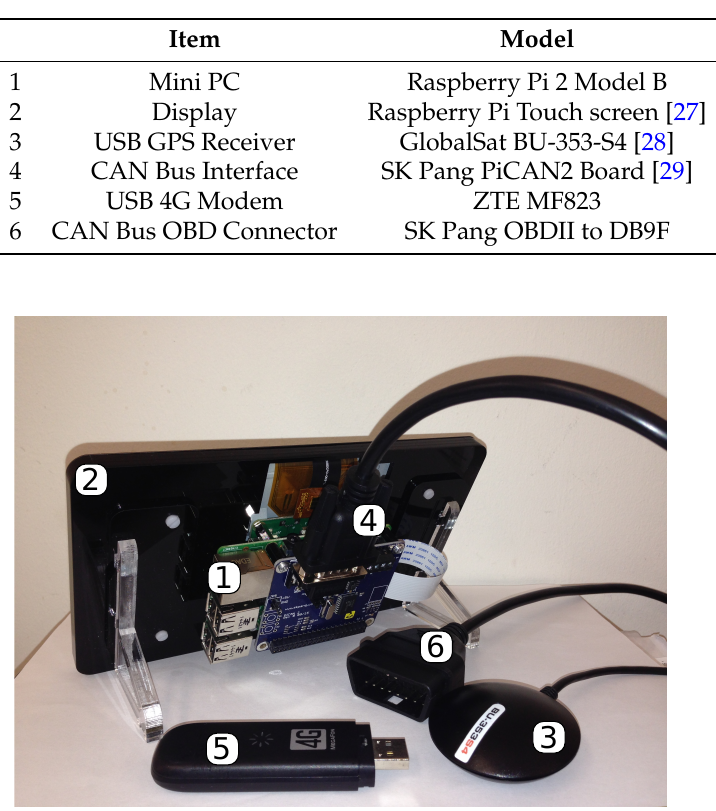
Table 1. Hardware components’ details.